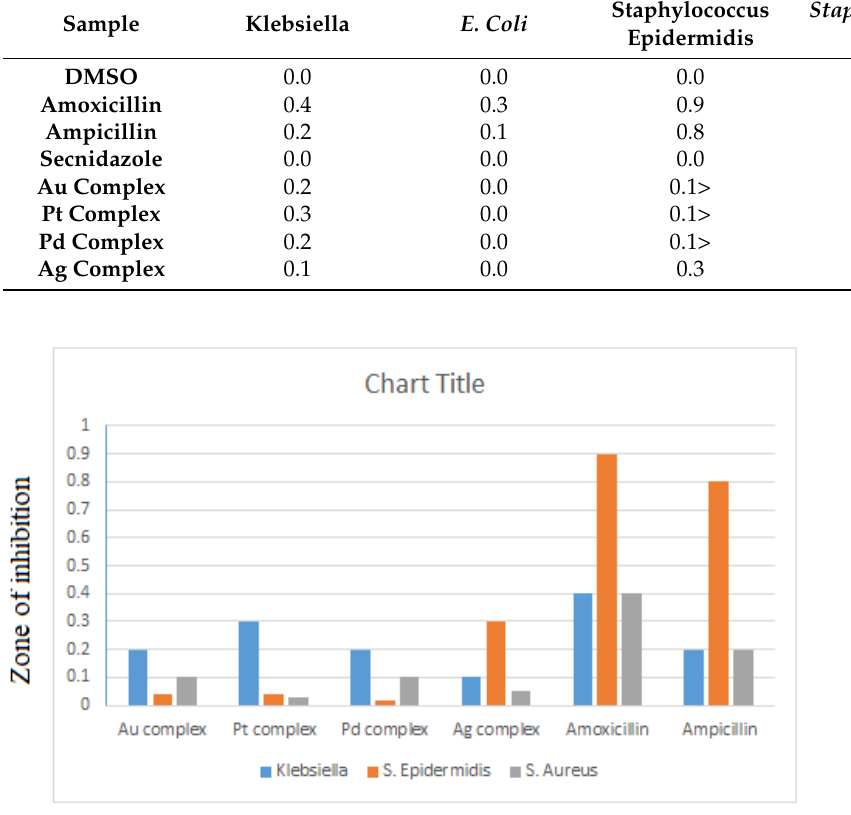
Figure 5. Antibacterial activities of the new synthesized complexes against Klebsiella, epidermidis, and S. aureus . Table 4. Growth inhibition zone of the four synthesized complexes.